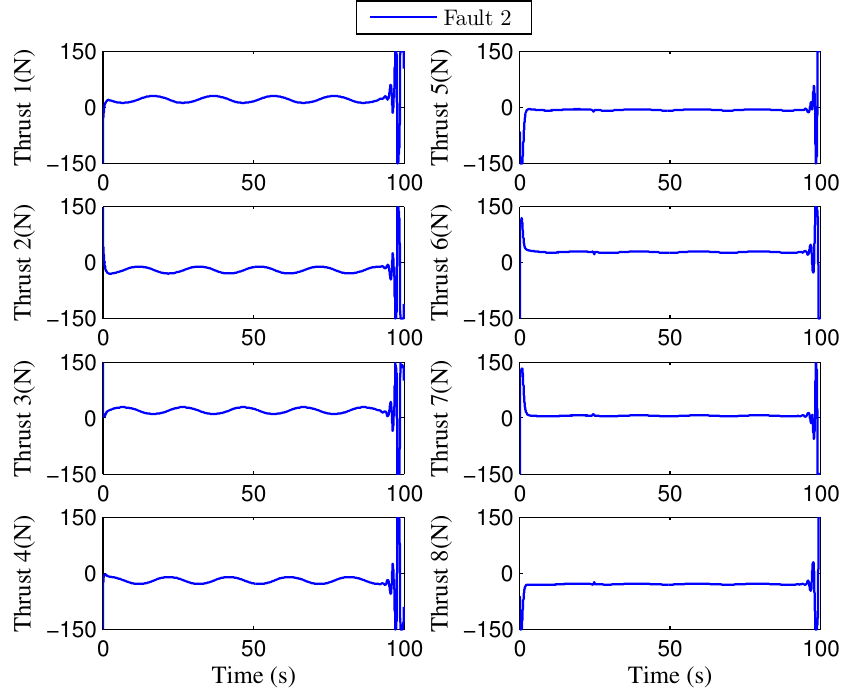
Figure 11. Outputs of thrusters with fault 2 under APISM-FTC